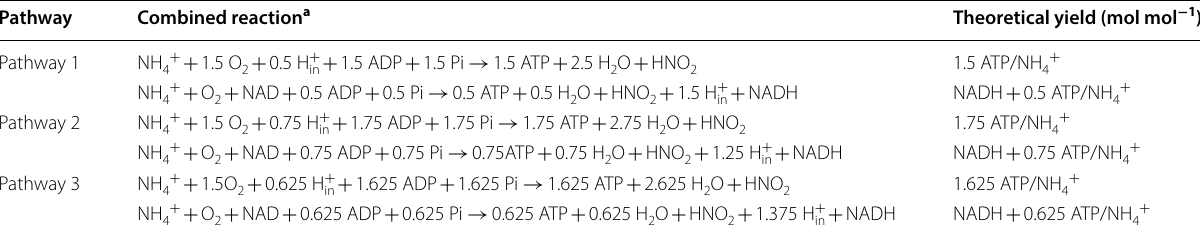
a Protons generated by the oxidation of NH 4 + can be used to produce ATP and NADH. The two combined reactions represent two situations when ATP or NADH production was maximized, respectively